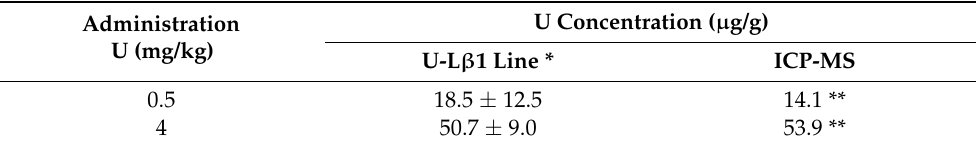
Table 3. Uranium concentration in urine administration specimens determined by calibration line of U-L β 1